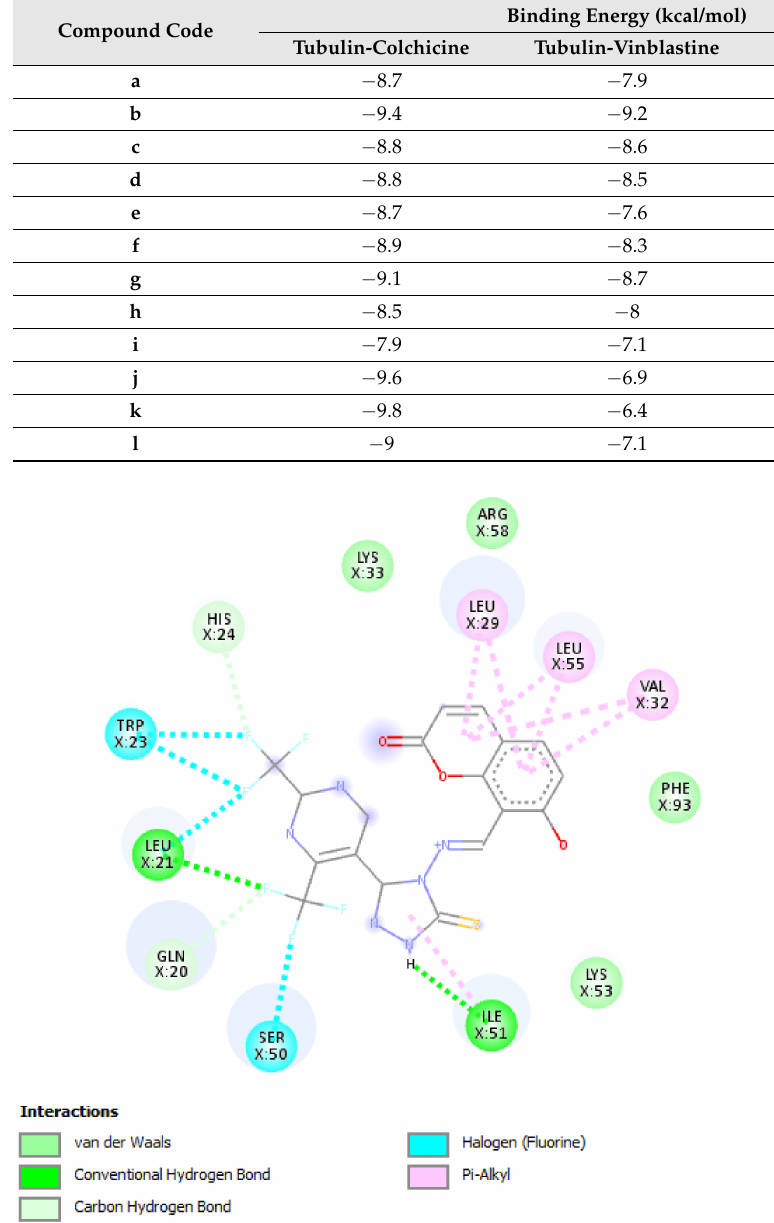
Figure 5. Docking interactions of designed compound g with DHFR